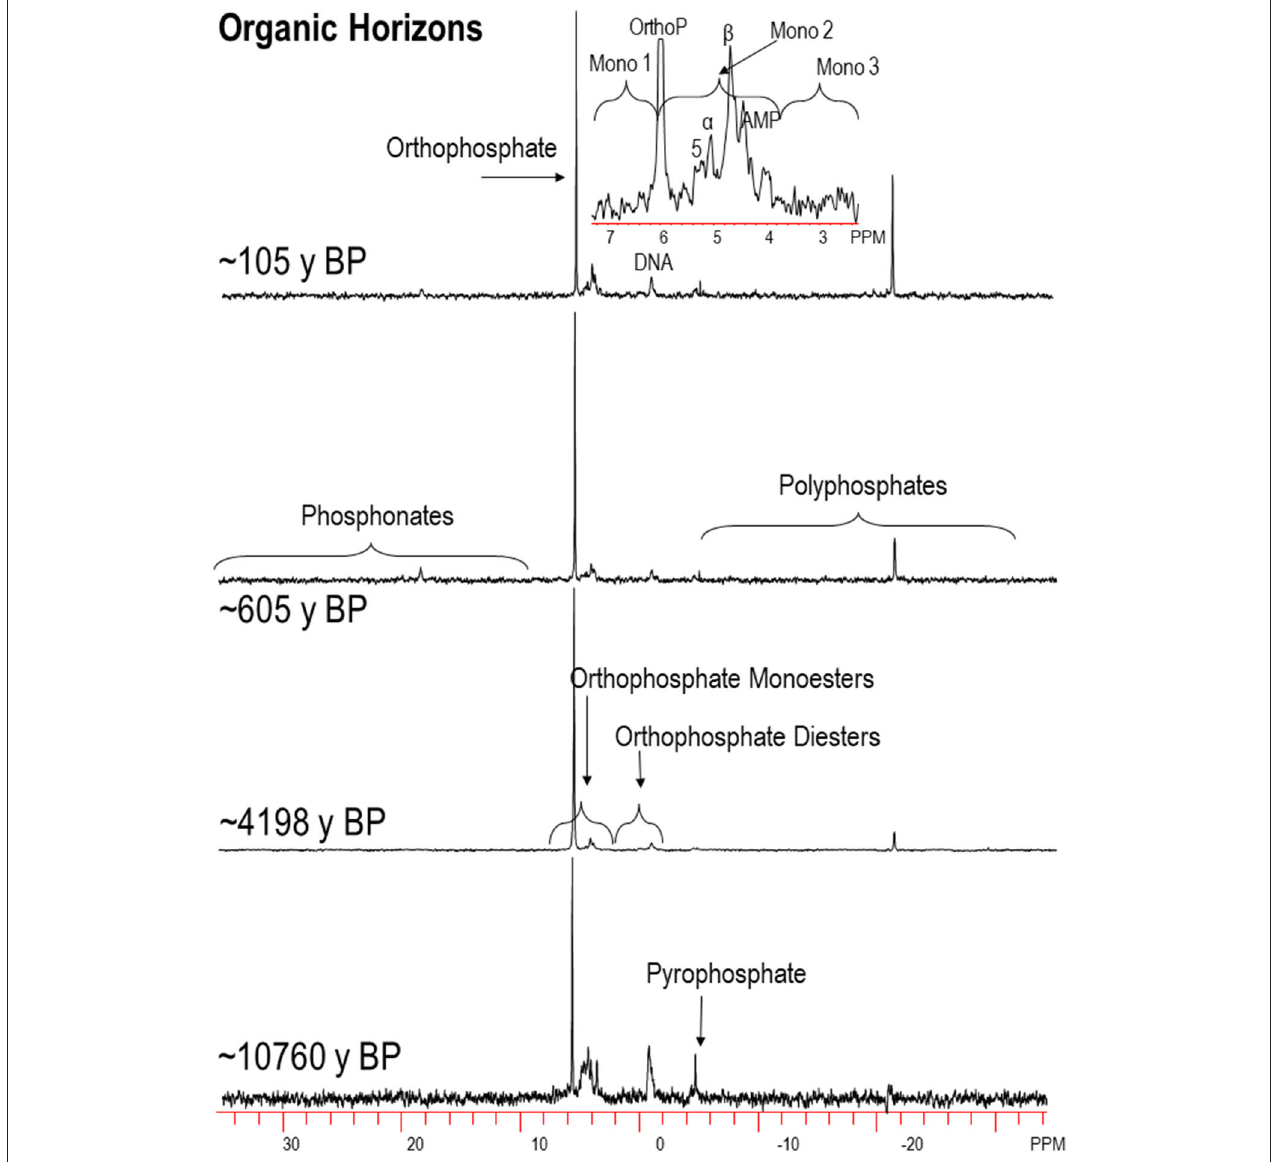
FIGURE 3 | Select 31 P-NMR spectra for humic-enriched organic (H) horizon samples along the Calvert Island chronosequence extracted with NaOH-EDTA and processed with 7Hz line-broadening. OrthoP, orthophosphate, Mono, orthophosphate monoesters; α , α -glycerophosphate; β , β -glycerophosphate; AMP, amino monophosphate; 5, unknown peak, 5 ppm; y BP, years before present. See text for more